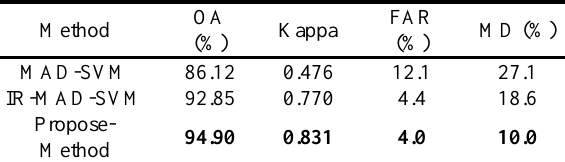
Table 4. The result of HCD for the USA